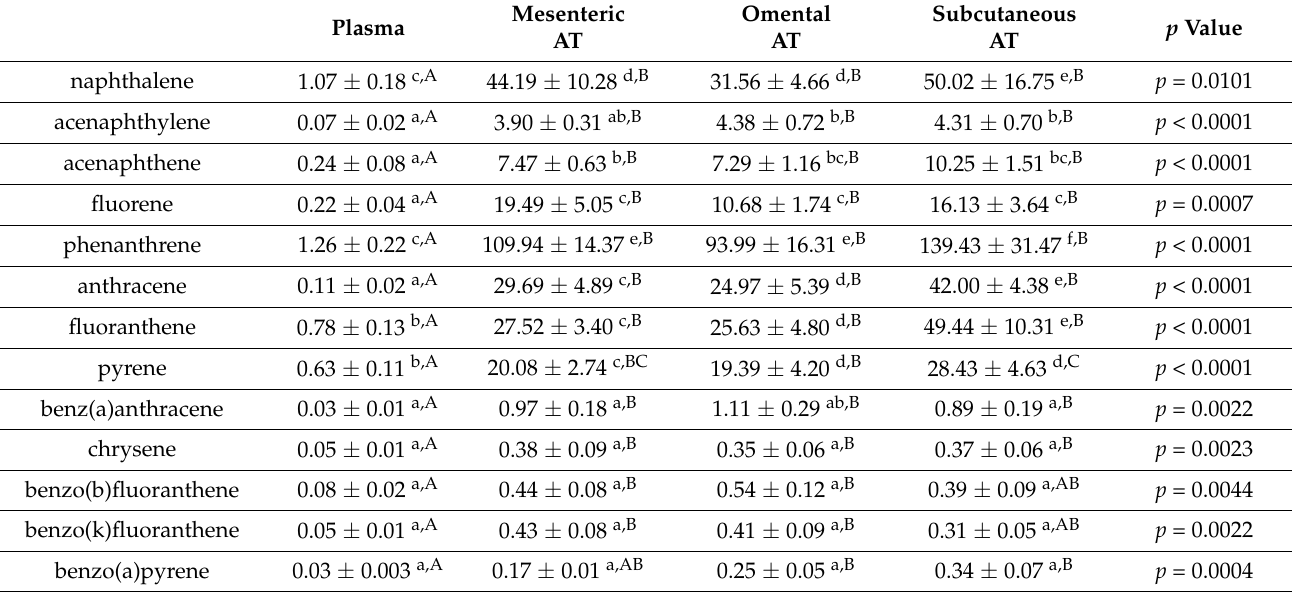
Table 3. Comparison of PAH concentrations between plasma (ng/mL) and three white adipose tissues (mesenteric, omental, and subcutaneous; ng/g) in Polish patients ( n = 10). Data are given as mean ± SEM, p ≤ 0.05. Different capital letters indicate a significant effect between different ATs and blood plasma whereas lower case letters indicate a significant effect between the 16